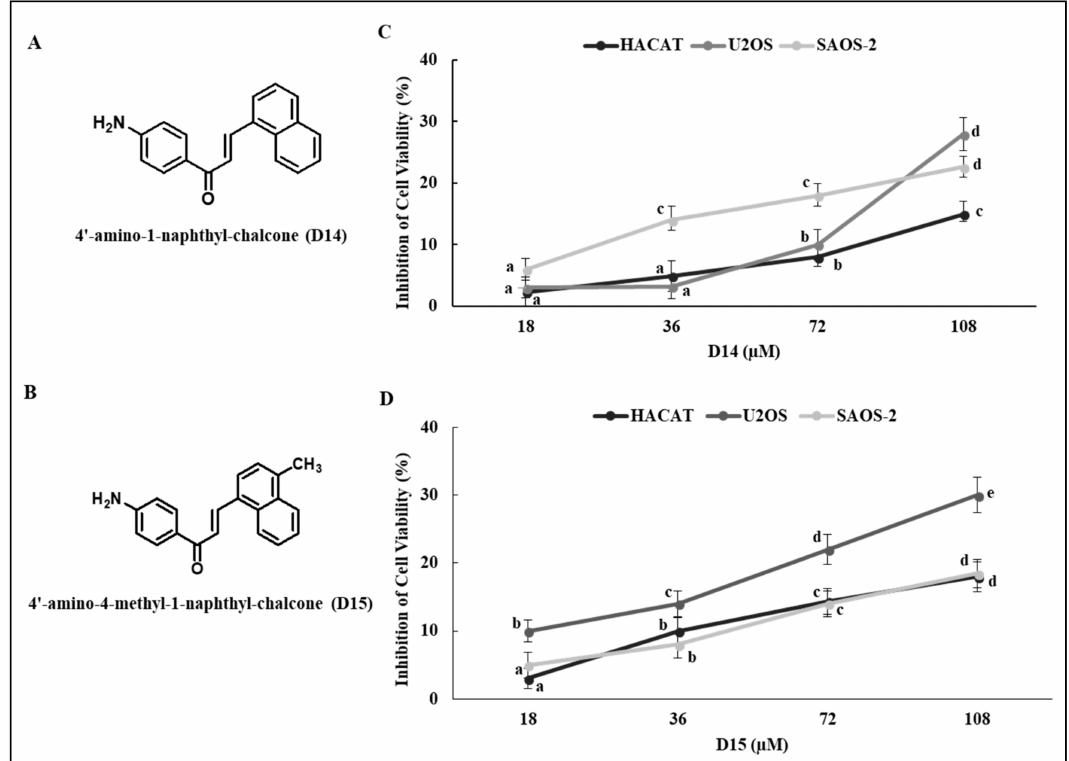
Figure 1. Inhibition of cell viability by D14 and D15 evaluated by MTT assay. ( A , B ) Chemical structure of D14 and D15. ( C , D ) Osteosarcoma cells (U2OS and SAOS-2) and human keratinocytes (HaCaT) were treated with the indicated concentrations of D14 and D15 for 24 h (control: cells treated with 0.1% DMSO). The values are expressed as means ± standard deviation of three individual experiments. Means followed by the same letter are not significantly different ( p < 0.05) according to Tukey’s HSD